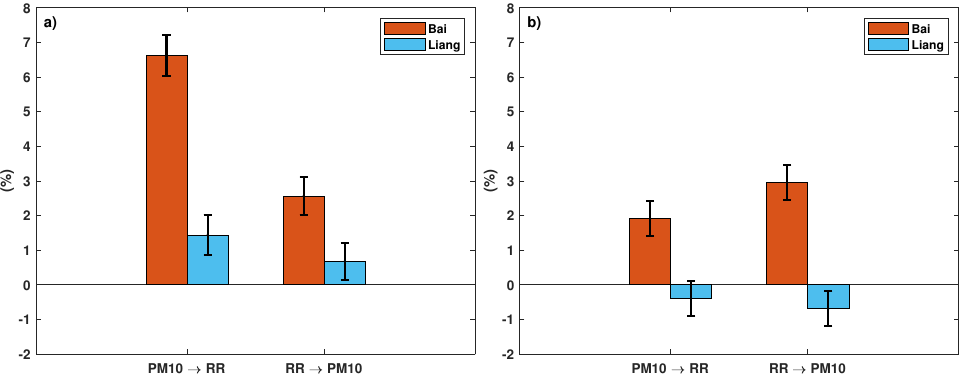
Figure 8. Relative information flow from PM 10 to RR and RR to PM 10 using Bai ( τ B , in or- ange) and Liang ( T L , in blue) methods for ( a ) high dust dry (May to June) and ( b ) high dust wet (July to September) seasons over 11 years. The standard error (95% significance level) is represented by the